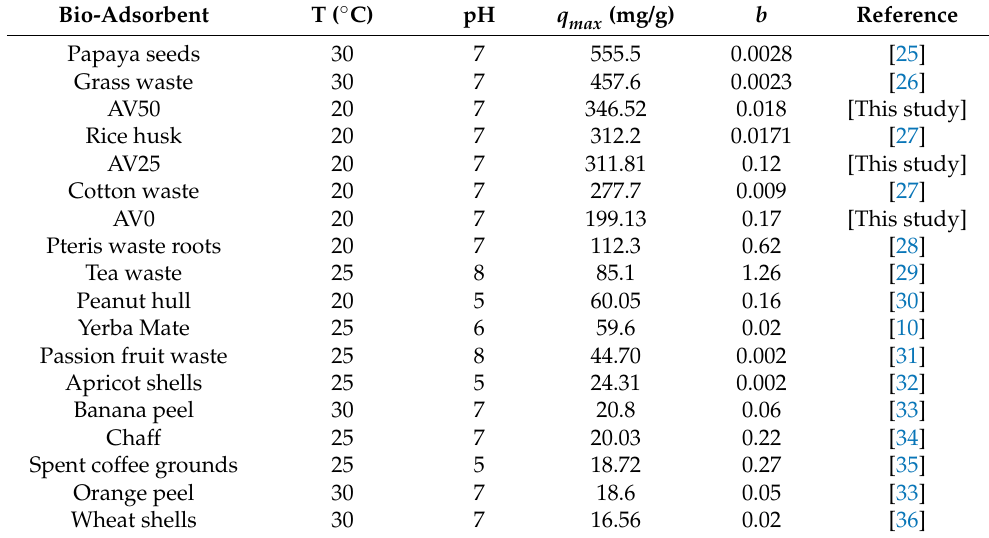
Table 2. Langmuir isotherm parameters for agro-waste adsorbents.